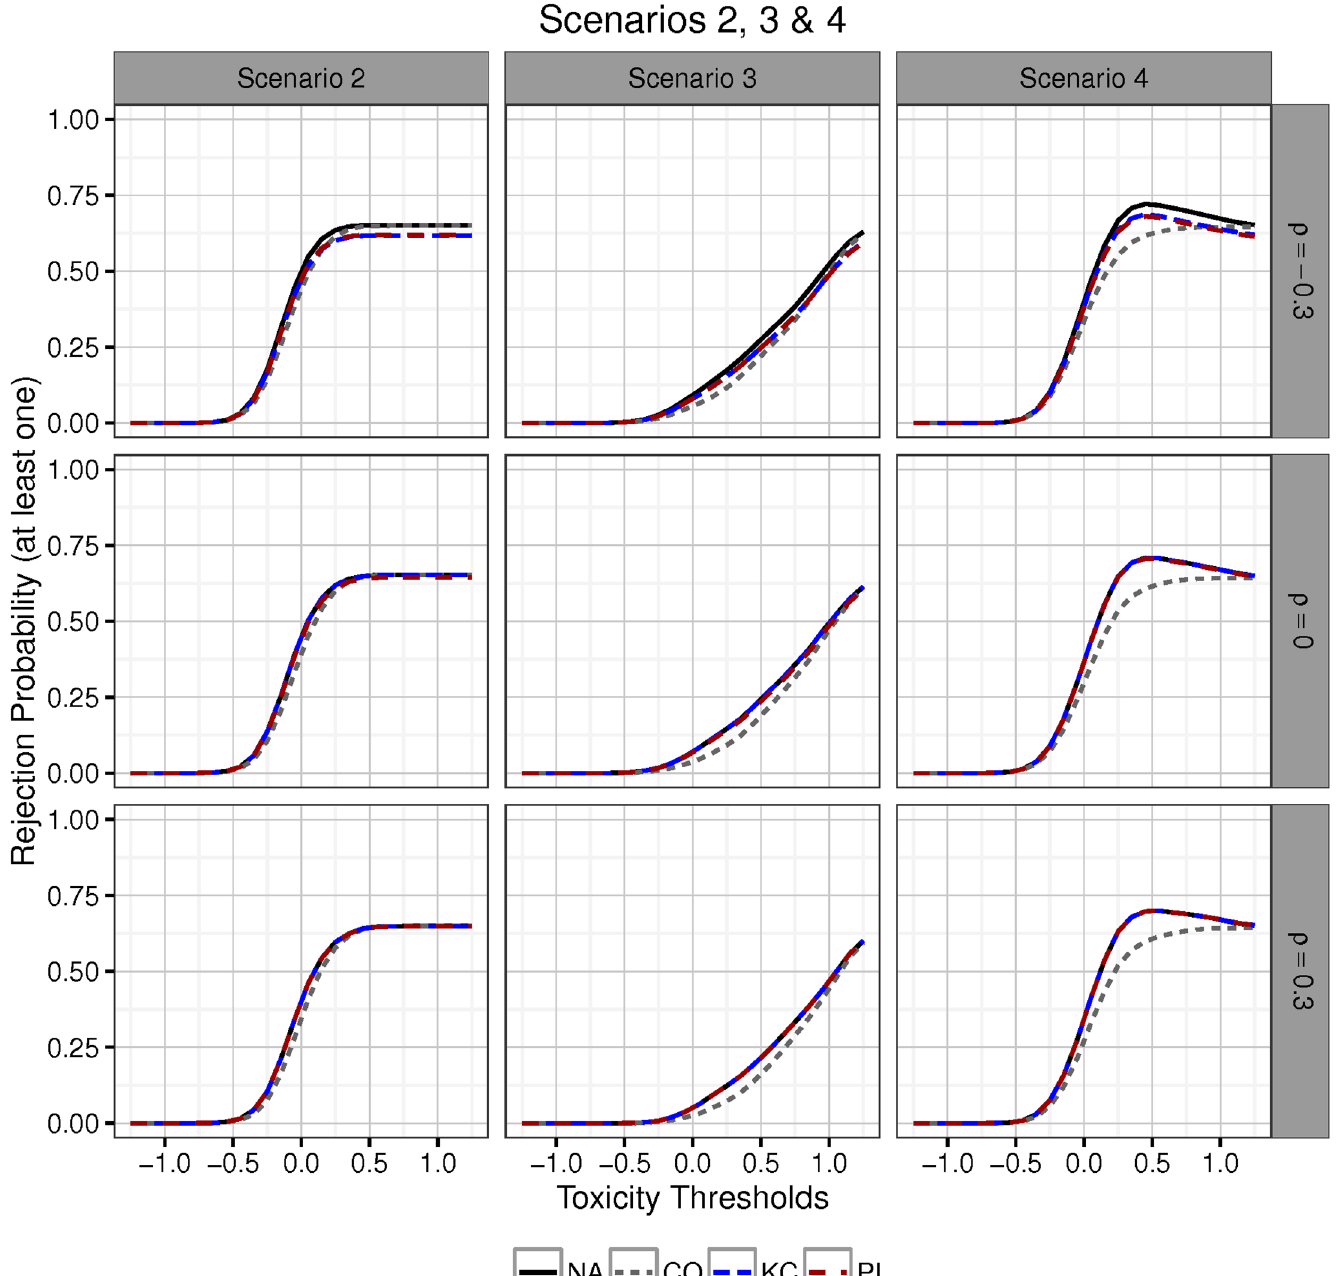
Fig 4. Power in Scenario 2 (left column), Scenario 3 (middle column) and Scenario 4 (right column). Different efficacy/toxicity patterns lead to varyinggains in power over procedureCO. Rows of figures are generatedsetting ρ = − 0.3, 0 or 0.3. In all scenarios, μ 3 = 0.8. The smallest gains in power are made in Scenario2, which representsan all-or-noneselectionsituation. Deviatingfrom this setting leads to gains in power in the area where dropping treatments is expected(Scenarios3 and 4). The largest power gains are seen in Scenario4 where the slopes of the linear configurations of the toxicity and efficacy means are of different